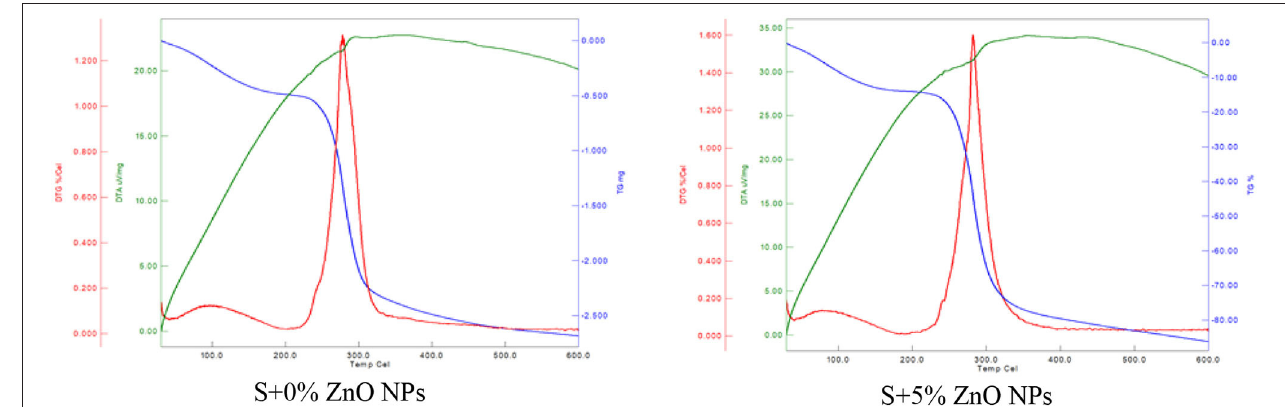
FIGURE 5 | Thermogravimetric analysis (TGA) of the bionanocomposite